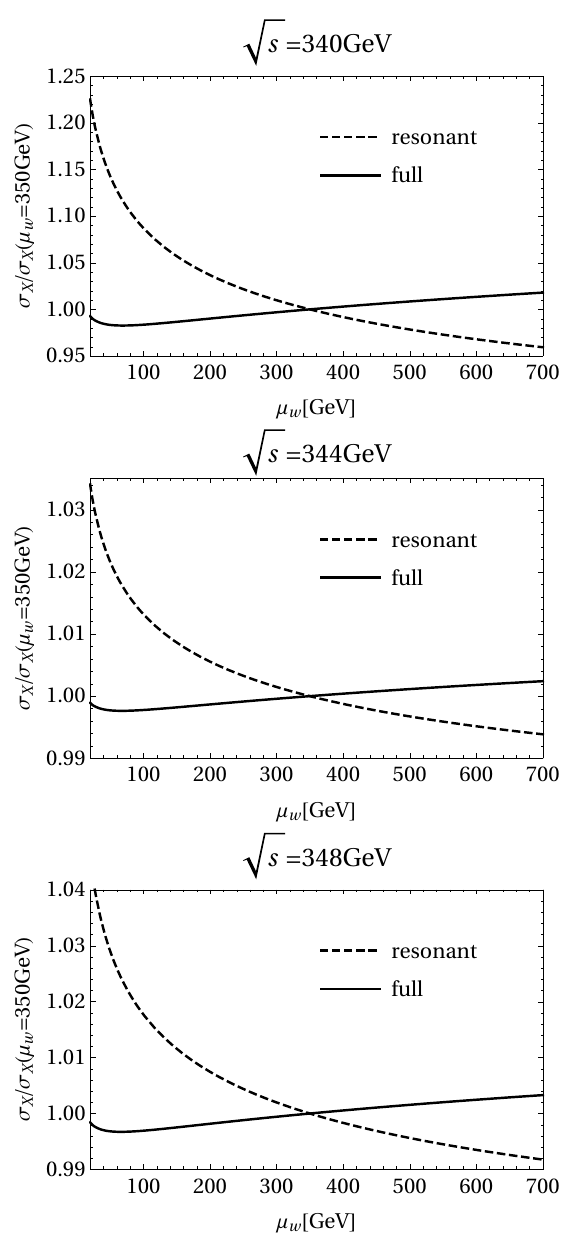
Figure 12 . Dependence of the resonant-only and full cross section on the scale (cid:22) to the one at (cid:22) w = 350 GeV for p s = 340 GeV (top panel), p s = 344 GeV (middle panel) and p s = 348 GeV (bottom